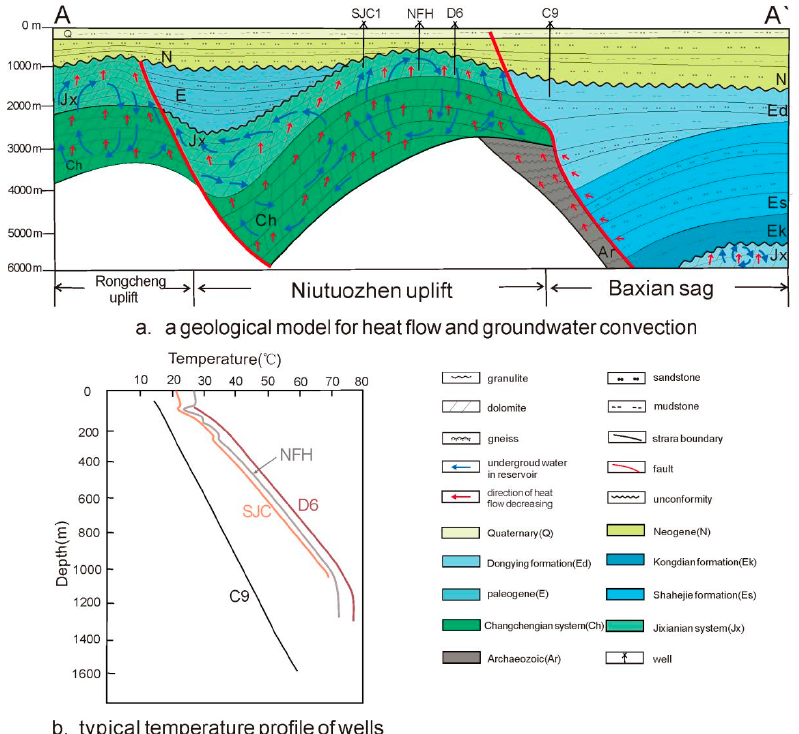
Figure 15. Geological model for heat flow and groundwater convection in section AA’ (for location, see Figure 2a) of the Xiong’an New Area. A geological model for heat flow and groundwater convenction ( a ); Typical temperature profile of wells ( b ) C9 well is in Baxian sag and NFH1, SJC1, and D6 well are in Niutuozhen uplift. Temperature profile of typical wells provides evidence to the temperature distribution